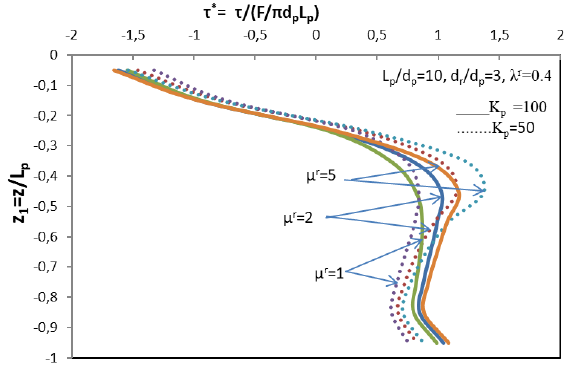
, with the normalized depth, z r , of GP and strengthening p